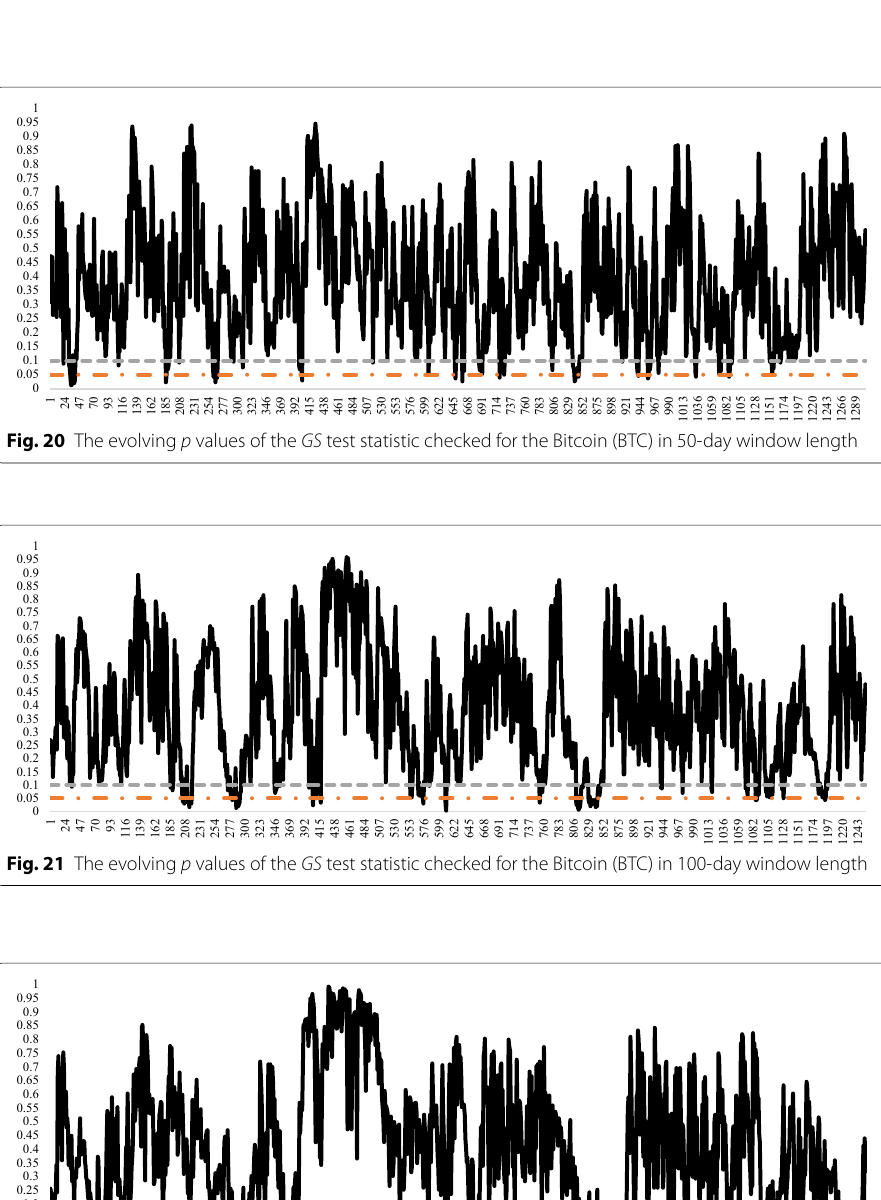
00.050.10.15 Fig. 22 The evolving p values of the GS test statistic checked for the Bitcoin (BTC) in 150-day window